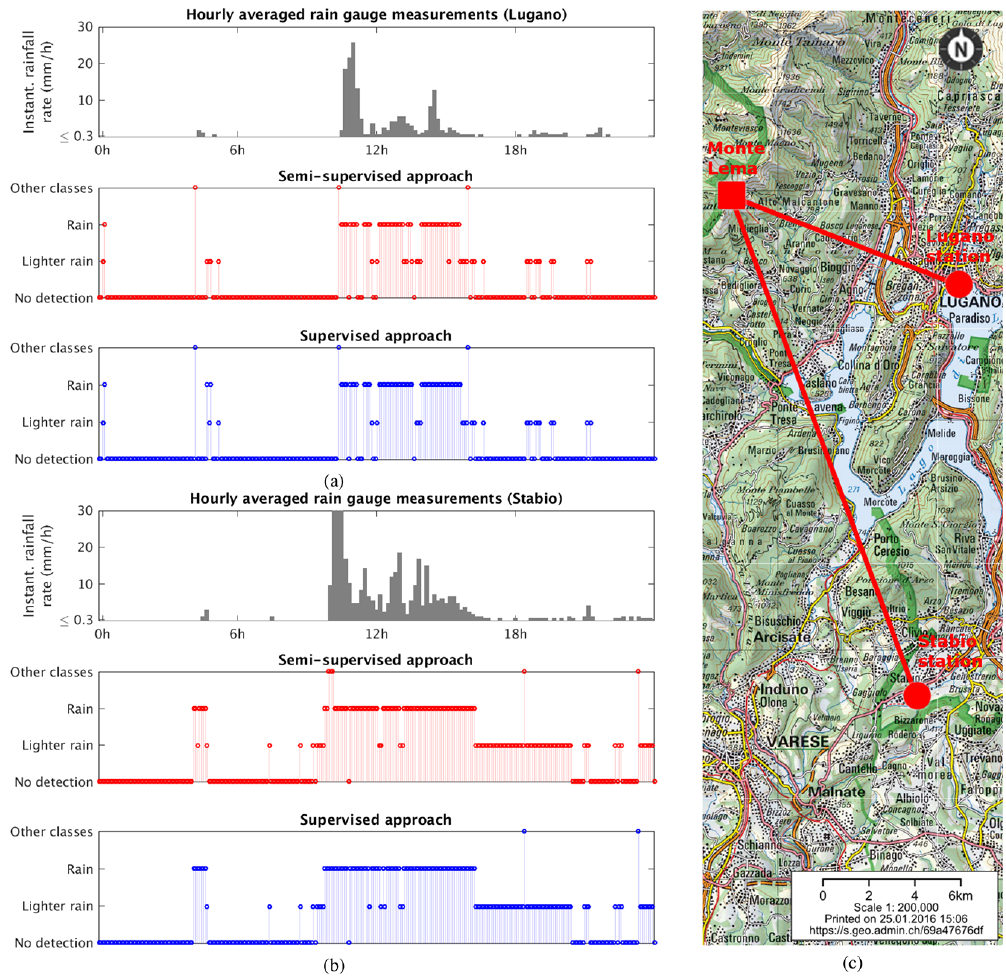
Figure 12. Comparison of light rain/rain/other classes classification, with the rain-gauge measurements – Monte Lema radar, 14 June 2015: (a) Lugano station; (b) Stabio station; (c) map of the region ( © Swiss federal authorities, 2007).